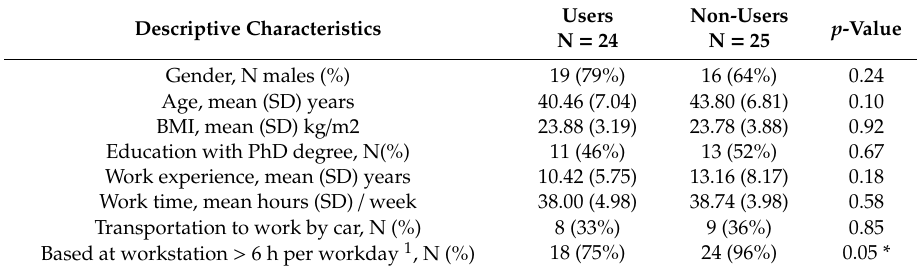
Table 1. Descriptive characteristics, including the use of the standing option for